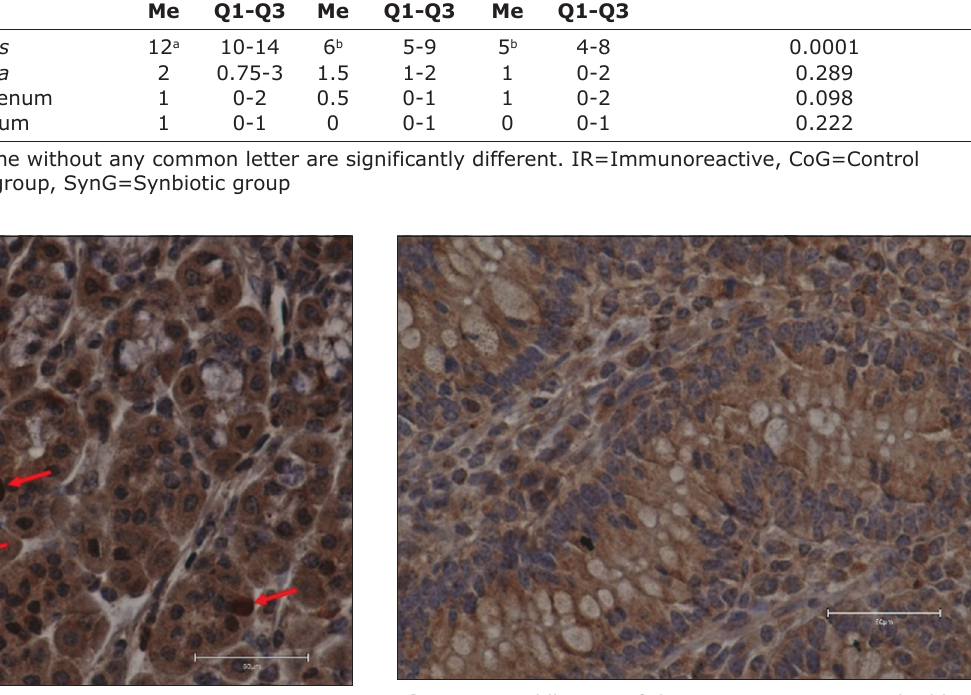
Figure-5: Middle part of the jejunum in a 13-week-old calf from the prebiotic group – no ghrelin immunoreactive + cells observed (400×, DAB + hematoxylin, scale bar 50 µ m).